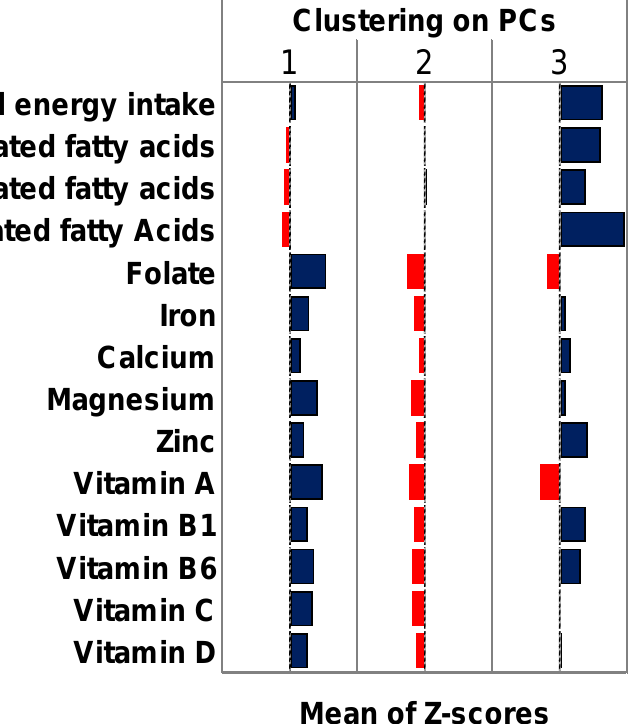
Figure 5. Comparison of z-scores of nutrient intakes between clusters obtained through clustering of principal components. Blue bars represent nutrient intakes that positively characterize the cluster. Red bars represent nutrient intakes that negatively characterize the cluster. Abbreviations: PCs, principal components.